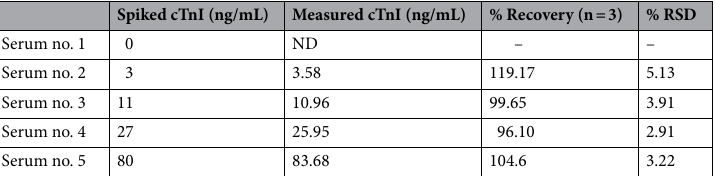
Table 1.. Application of the developed dip strip immunoassay for detection of cardiac troponin I in serum samples. All data were a mean of three replicated measurements (n = 3). ND, not